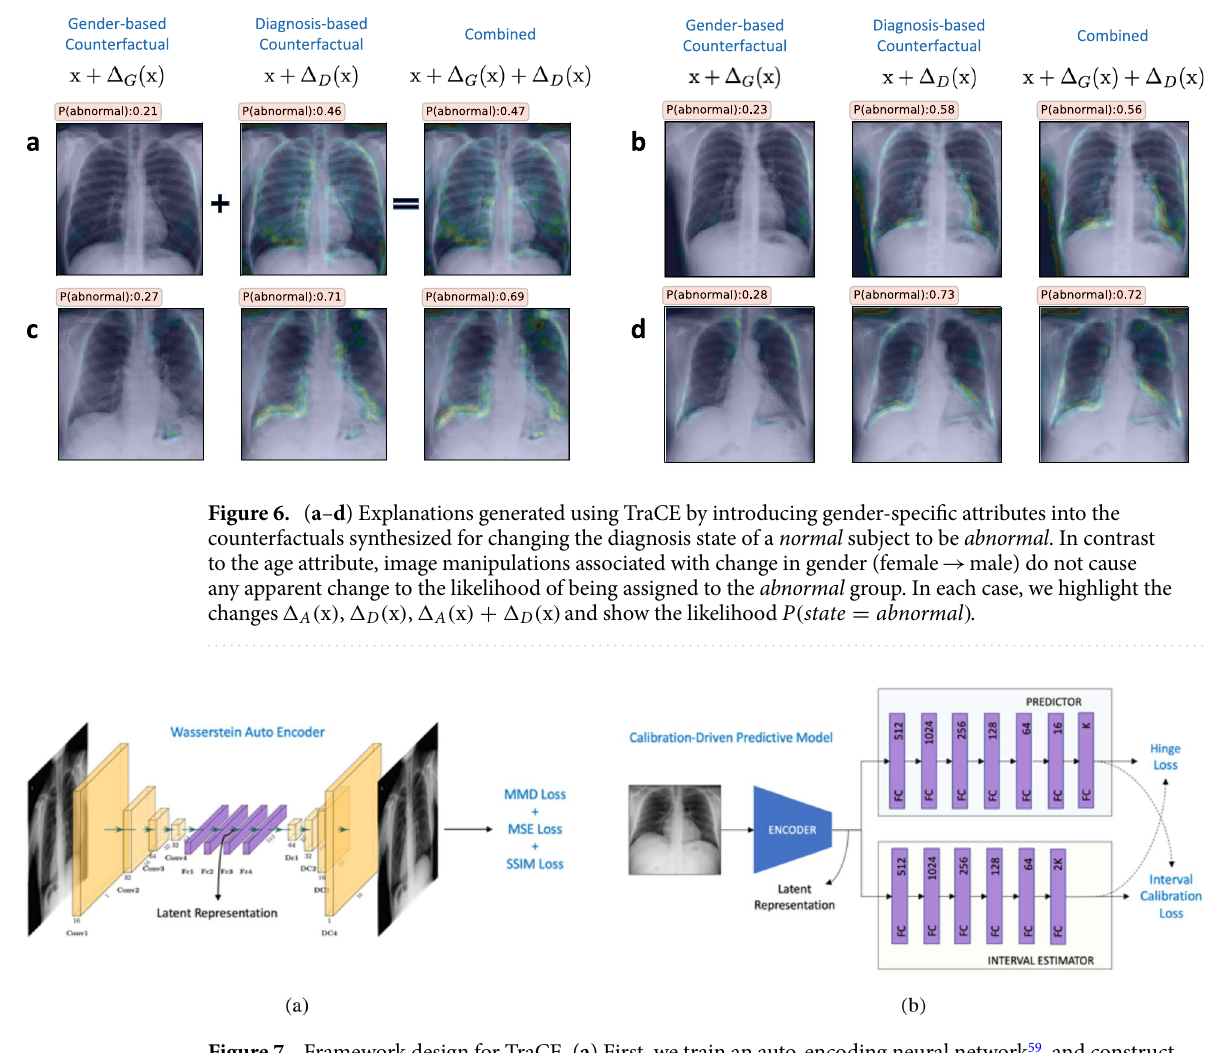
Figure 7. Framework design for TraCE. ( a ) First, we train an auto-encoding neural network 59 , and construct a low-dimensional, continuous latent space for CXR images. Note, we used a combination of maximum mean discrepancy (MMD), mean squared error (MSE) and structural similarity (SSIM) losses to train the network parameters; ( b ) next, we adapt the Learn-by-Calibrating 62 approach to train a classifier that takes as input the latent representation from the encoder and outputs a patient-specific attribute along with prediction